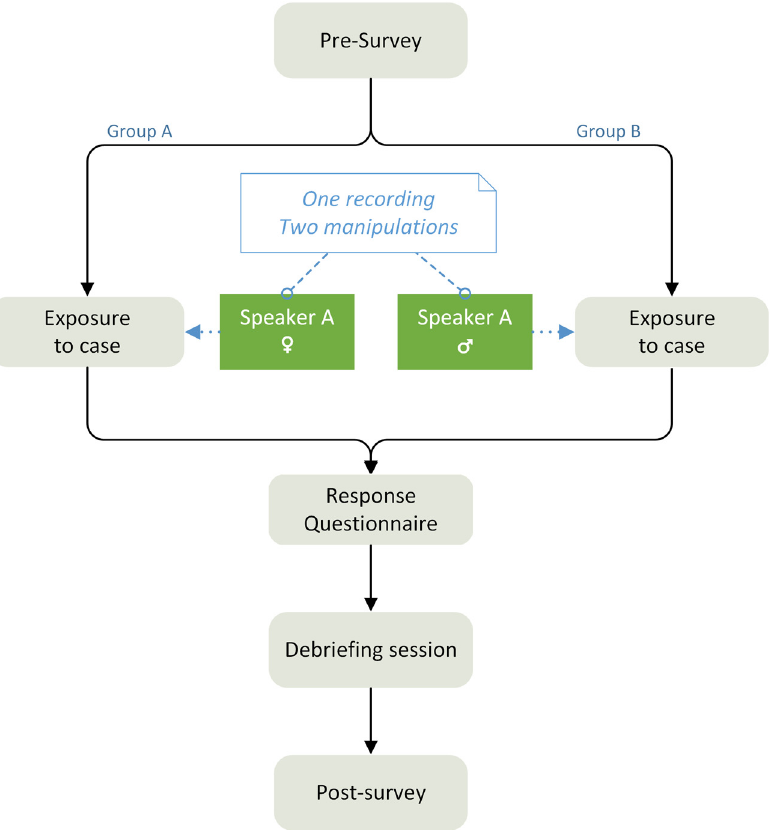
Figure 2: Overview of the matched - guise